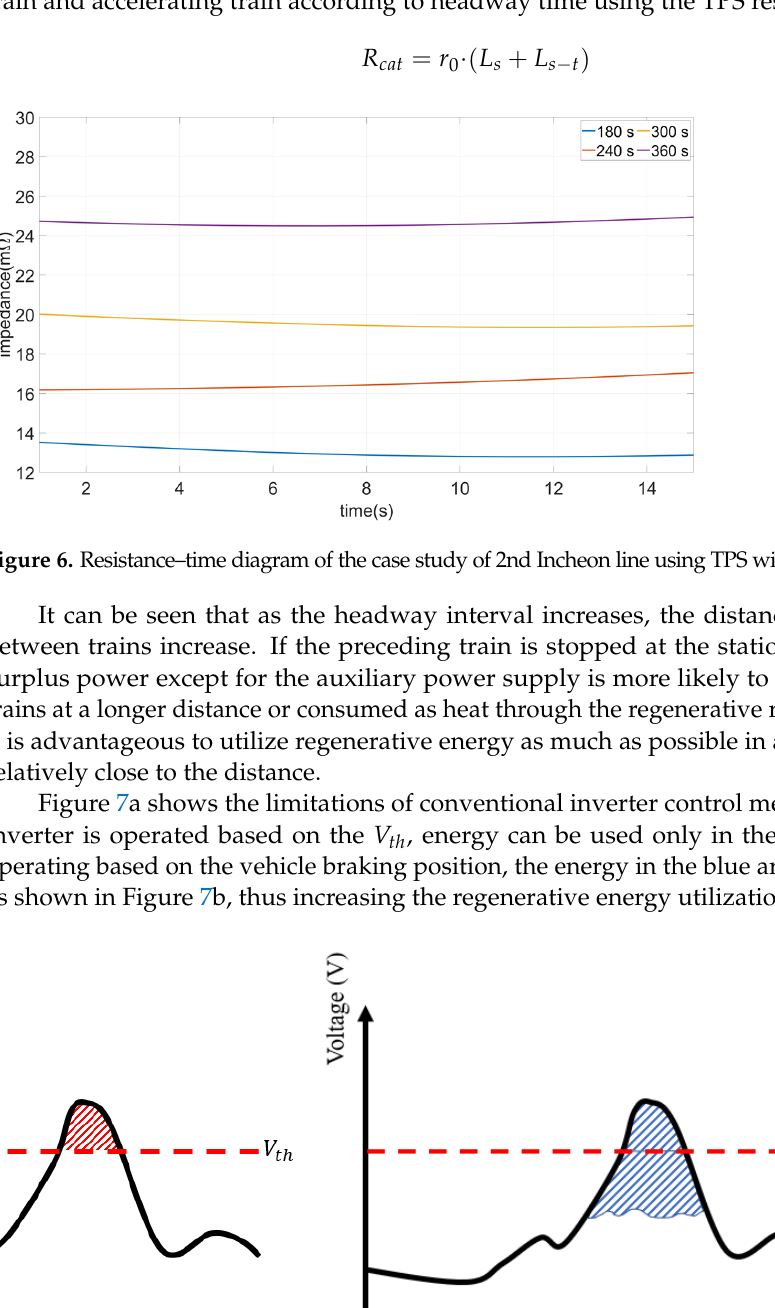
Figure 7. ( a ) Energy utilization area according to the conventional inverter operation method. ( b )